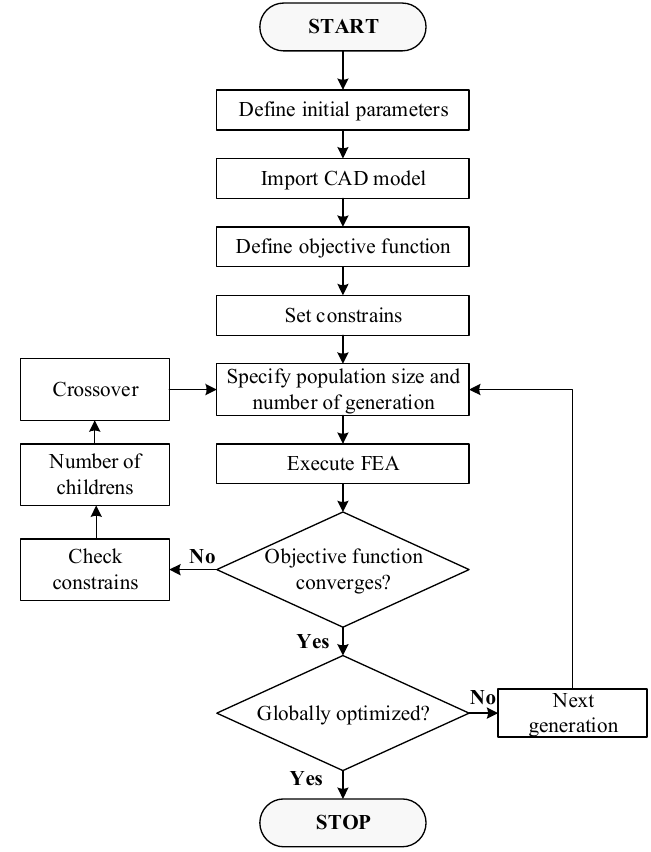
Figure 8. Flow chart of Genetic Optimization.